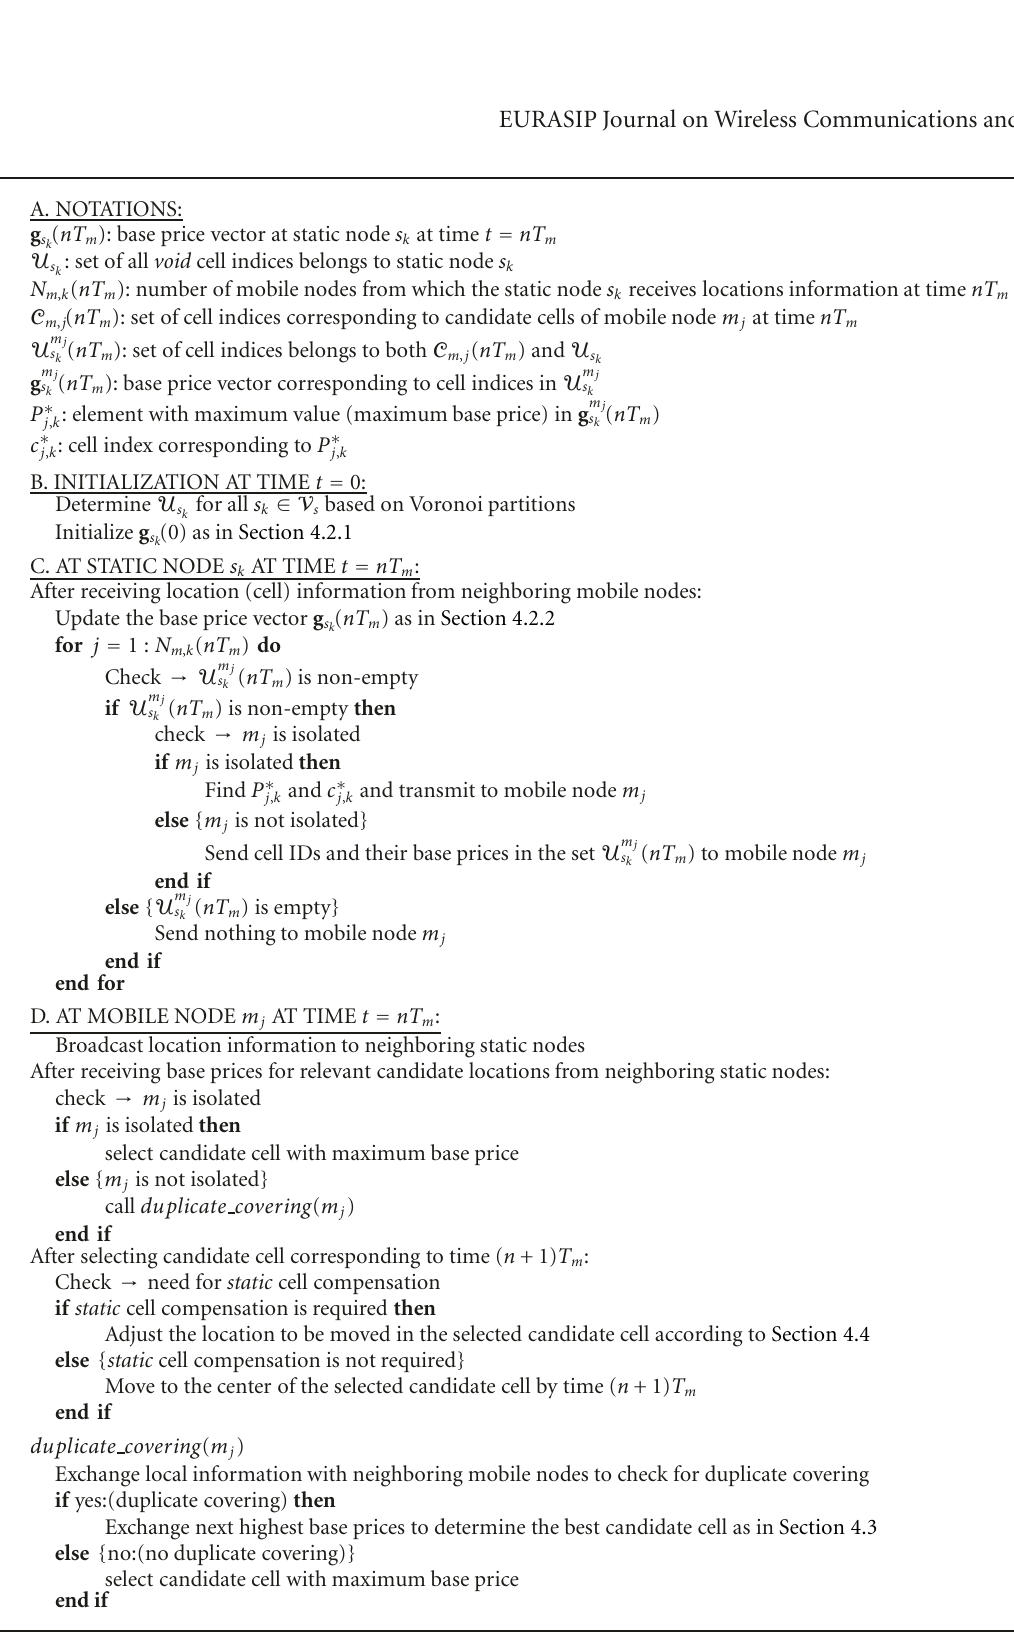
Algorithm 1: Mobile-static collaborative mobility